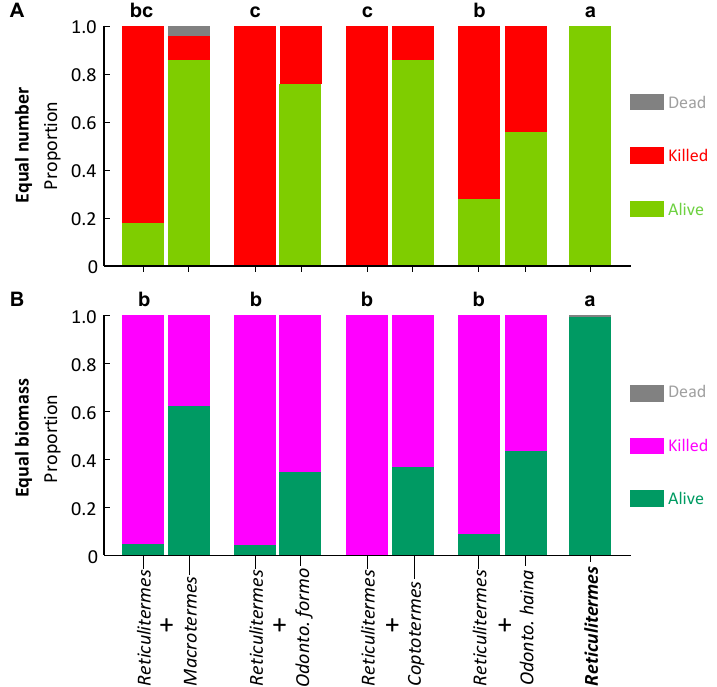
Figure 5. Survival of Reticulitermes flaviceps in laboratory aggression experiments. The control appears as a single column as it contains one species, whereas paired species treatments are paired columns, the R. flaviceps on the left of each pair. Columns surmounted by different letters signify significantly different proportion survival (Bonferroni corrected pairwise comparisons) for R. flaviceps . ( A ) Equal number of termites; ( B ) Equal biomass of termites.